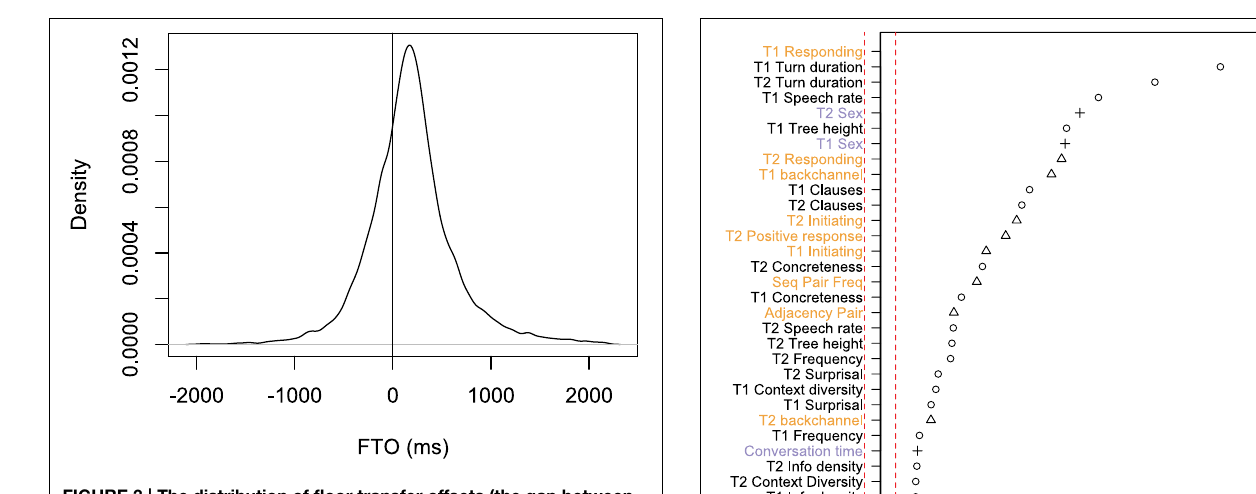
FIGURE 3 | The distribution of floor transfer offsets (the gap between two turns) for the Switchboard data.